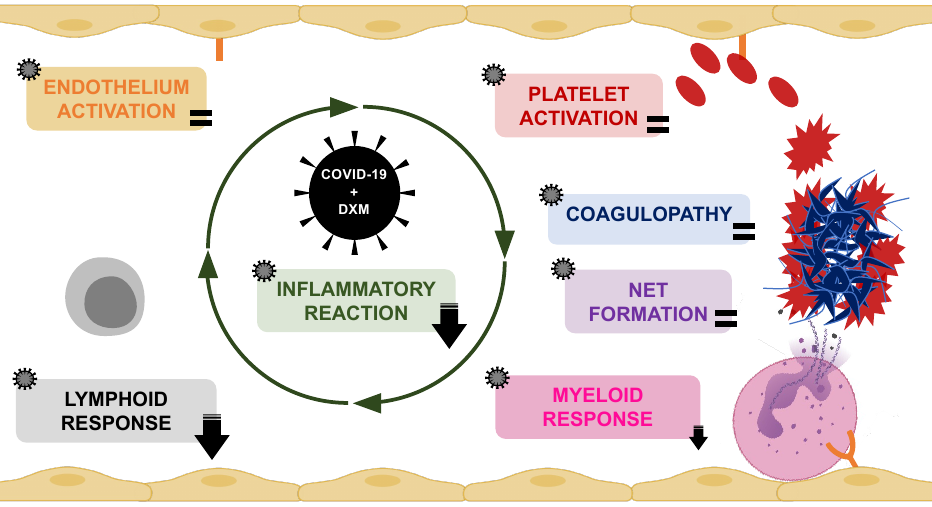
Figure 6. Overview of corticosteroid effects on the inflammatory and immune responses, endothelial and platelet activation, NETosis, and coagulopathy in patients with severe